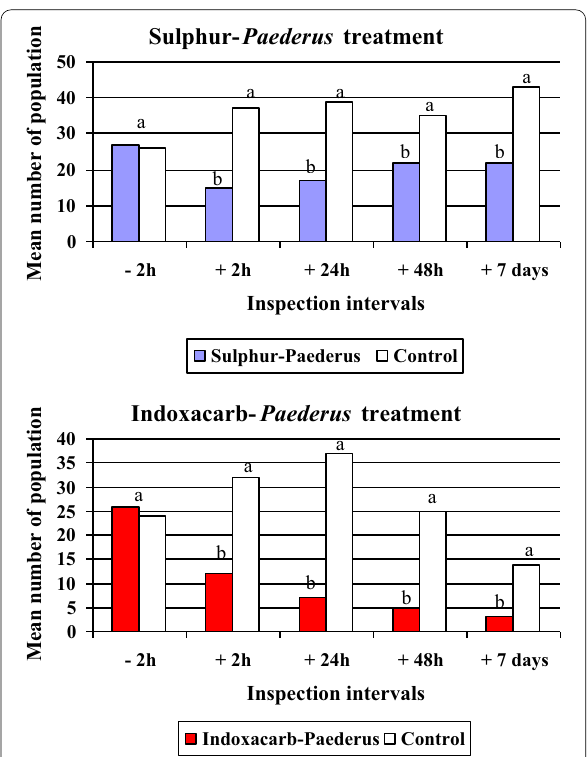
Fig. 5 Effect of indoxacarb and sorell 98% applications on the abundance of Paederus larvae and adults. Significant differences were calculated separately for each interval